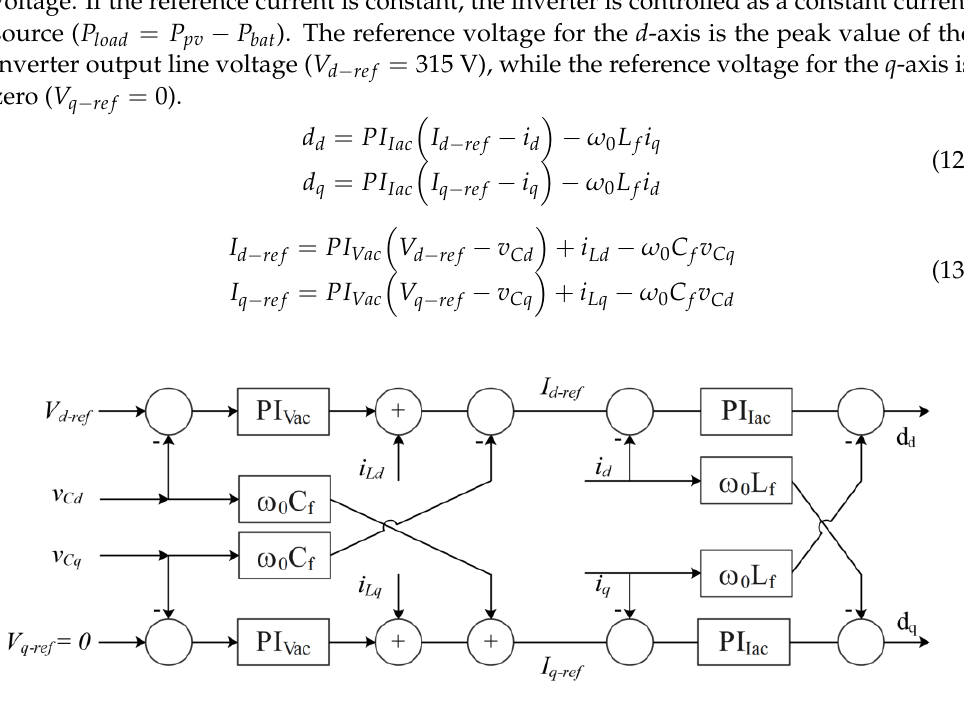
Figure 13 . Block diagram of inverter controller. Figure 13. Block diagram of inverter